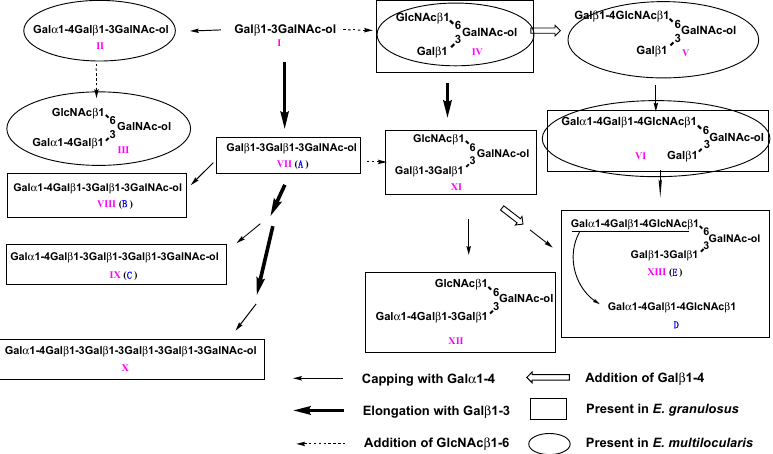
Figure 1. Correlation diagram of oligosaccharide structures of E. multilocularis and E. granulosus. Molecules 2021 , 26 , x FOR PEER REVIEW